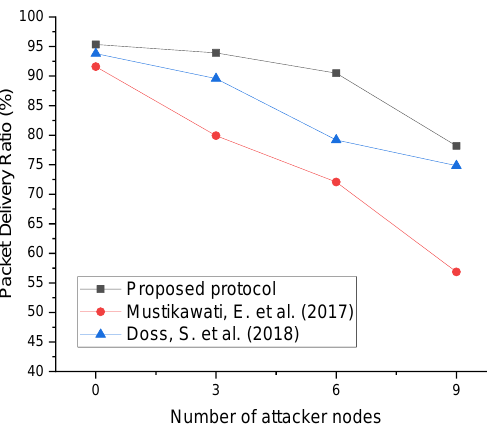
Figure 16. Packet delivery ratio under Jellyfish reordering attacks [20,37].